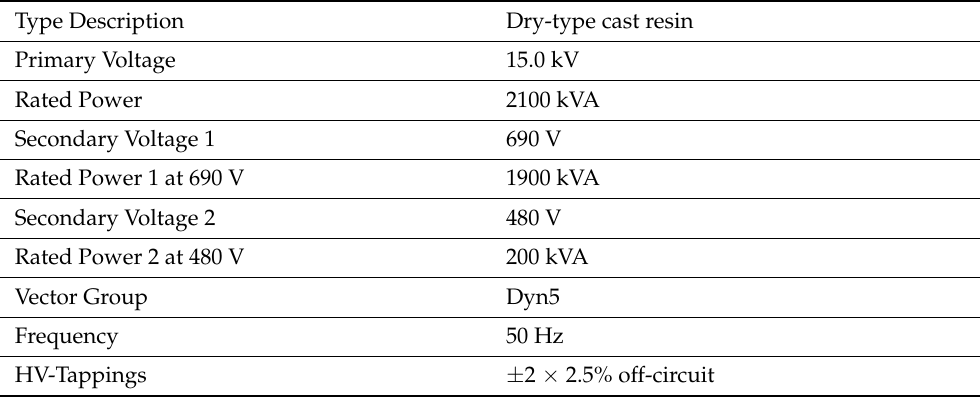
Table 3. Transformer